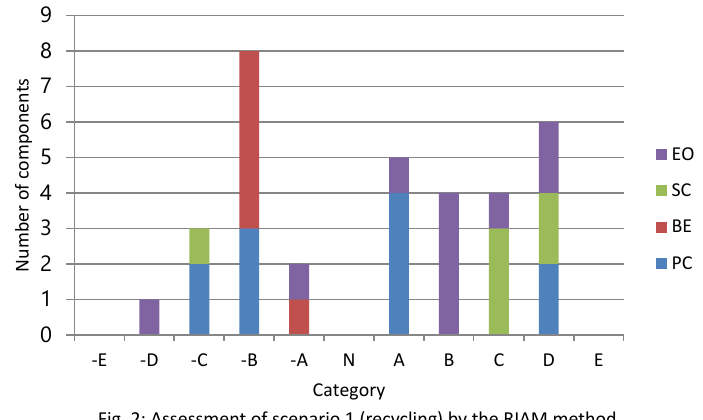
Fig. 2: Assessment of scenario 1 (recycling) by the RIAM method